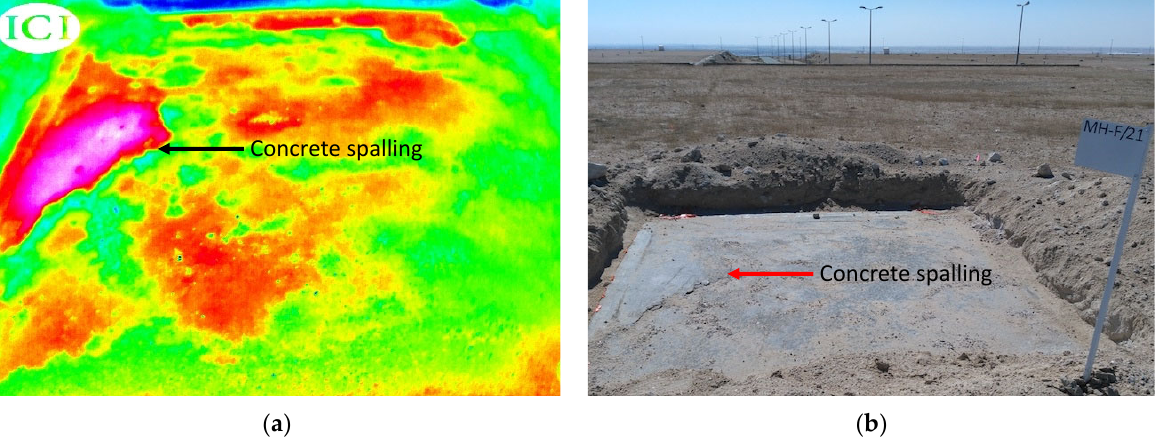
Figure 1. Images for the top surface of a water reservoir roof, showing the area with spalled concrete: ( a ) the infrared (IR) thermal image; ( b ) the corresponding visual image. The arrow indicates an area of concrete spalling caused by severe steel corrosion.